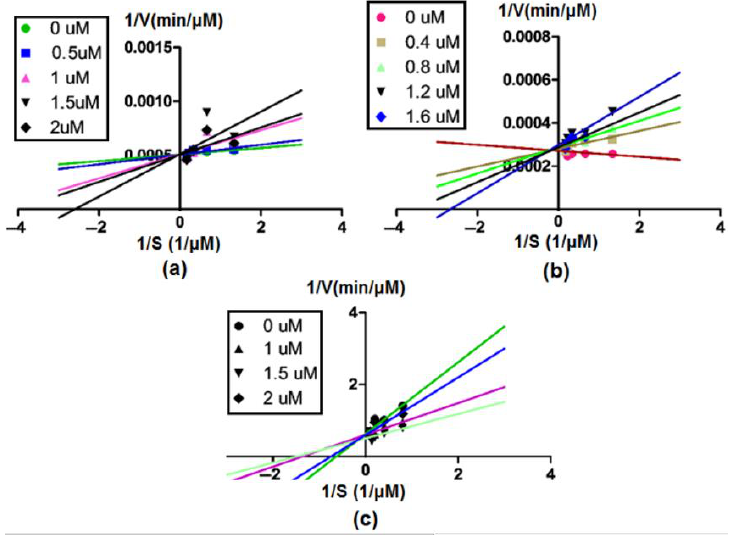
Figure 3. The double reciprocal plot of ( a ) MAO-A, ( b ) MAO-B, and ( c ) AChE activity in the presence and absence of different concentrations of the most promising compounds ( 5a , 5f , and 5c ).